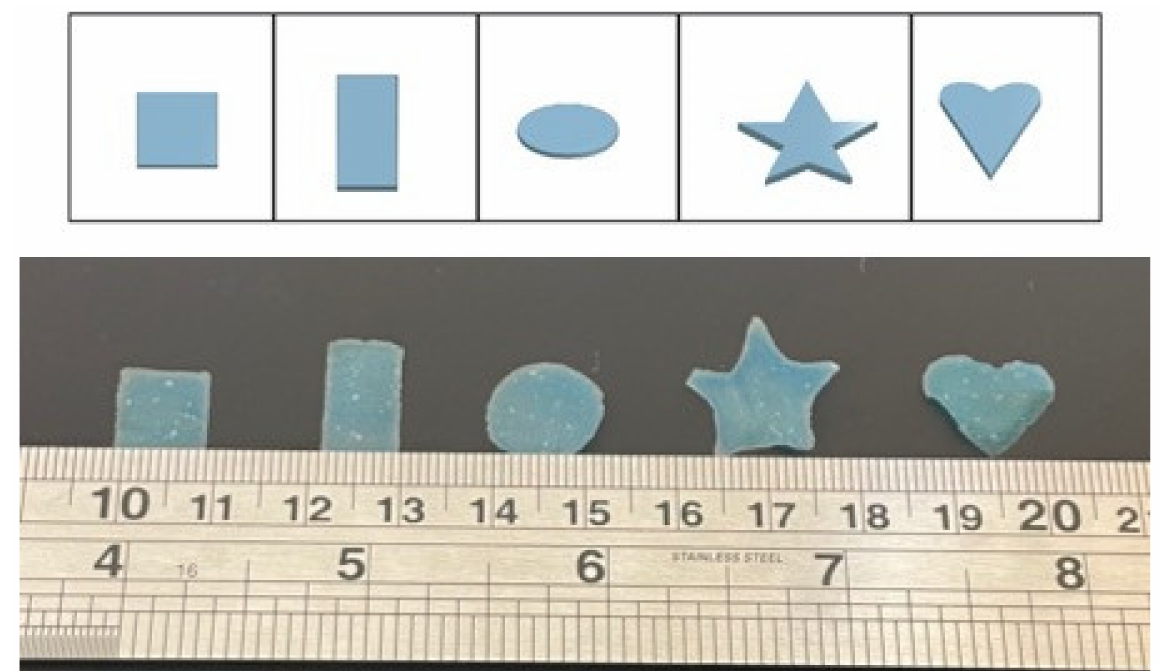
Figure 1. Examples of CAD designs of shapes (square, strip, circle, star, heart) used in this study ( top ) and examples of 3DP printed ODFs corresponding to the CAD designs ( bottom ) (Ruler markings in